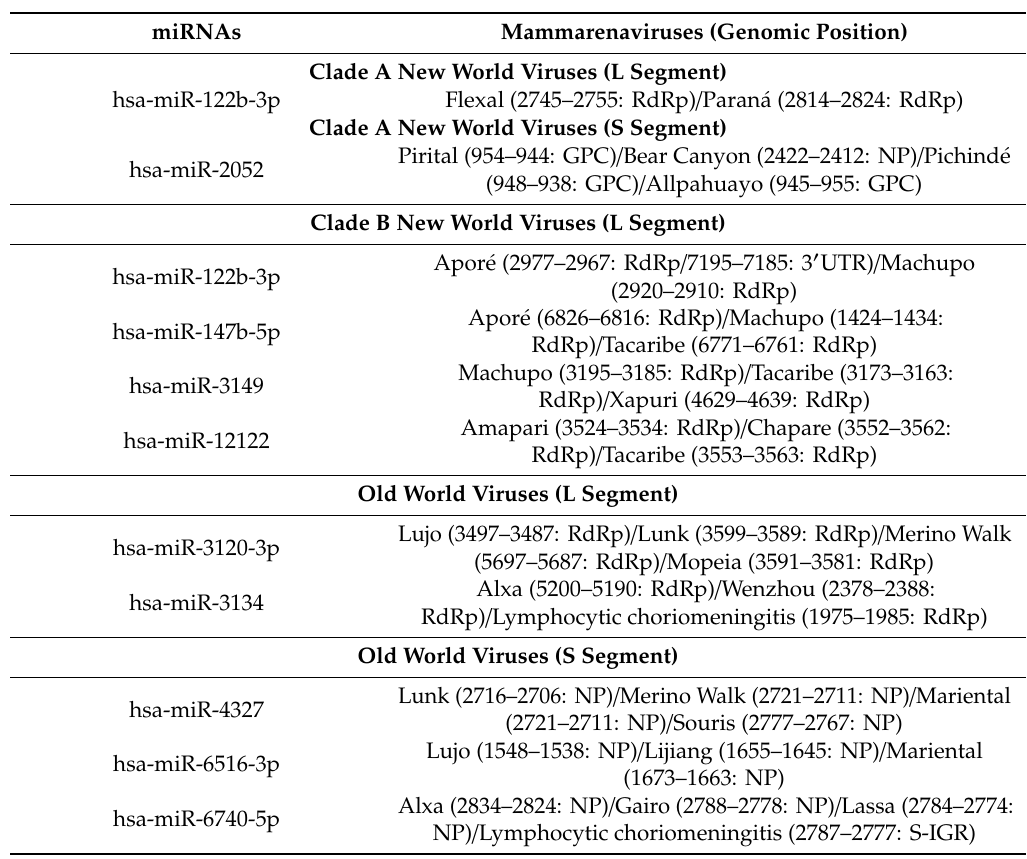
Table 2. List of top 10 miRNAs binding to di ff erent regions of same the RNA segment of di ff erent mammarenavirus